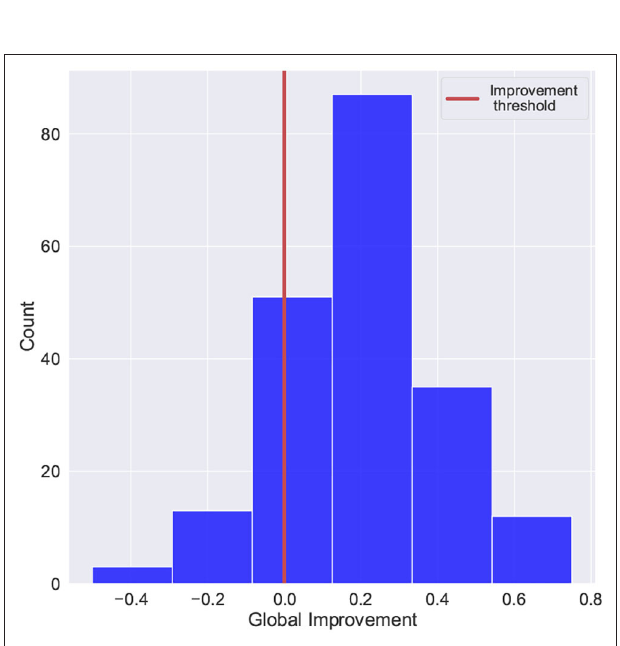
FIGURE 5 | Scores distribution of global improvement. Class “0”: global improvement<=0 , Class “1”: global improvement>0 .